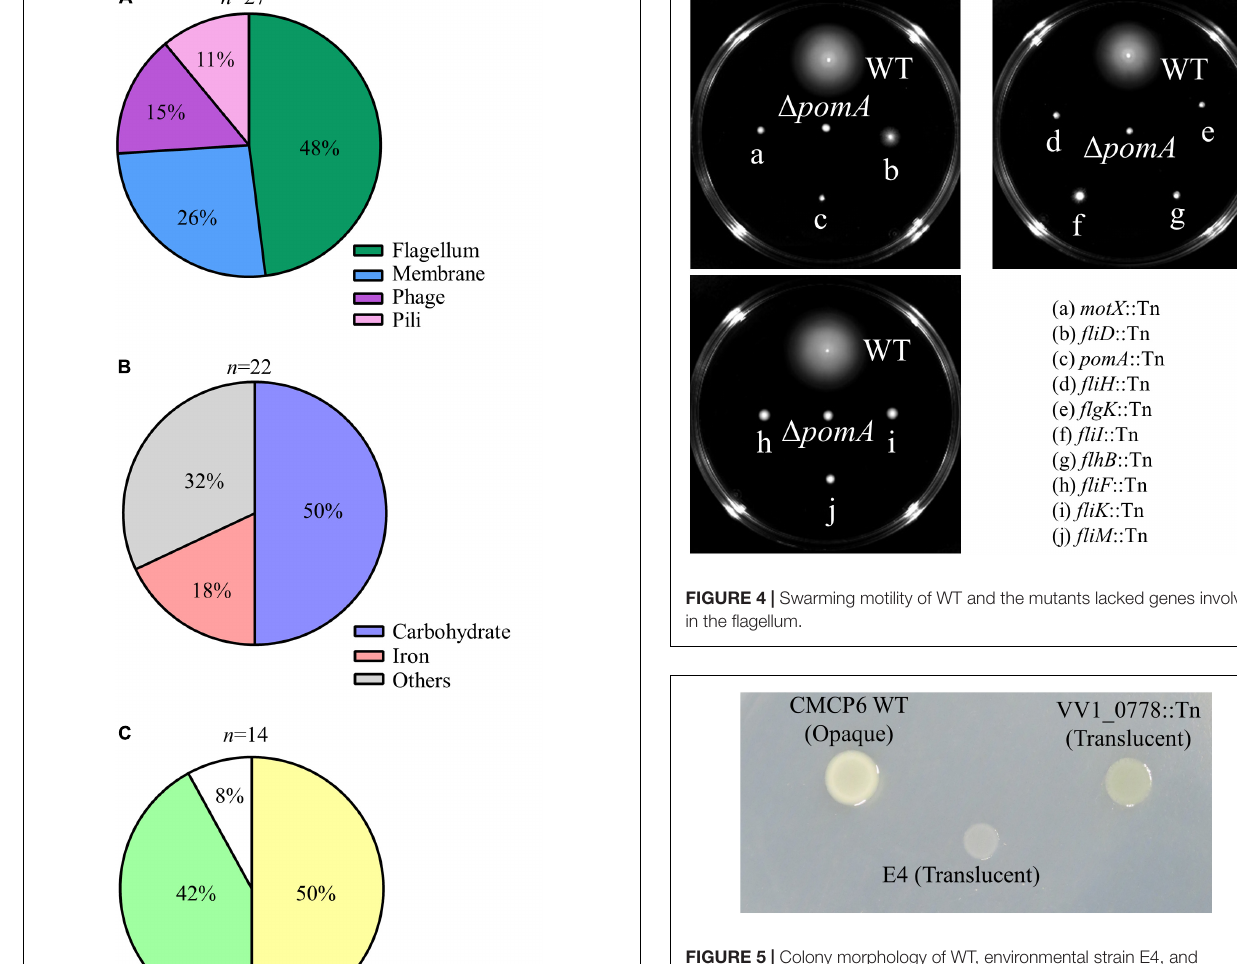
FIGURE 5 | Colony morphology of WT, environmental strain E4, and